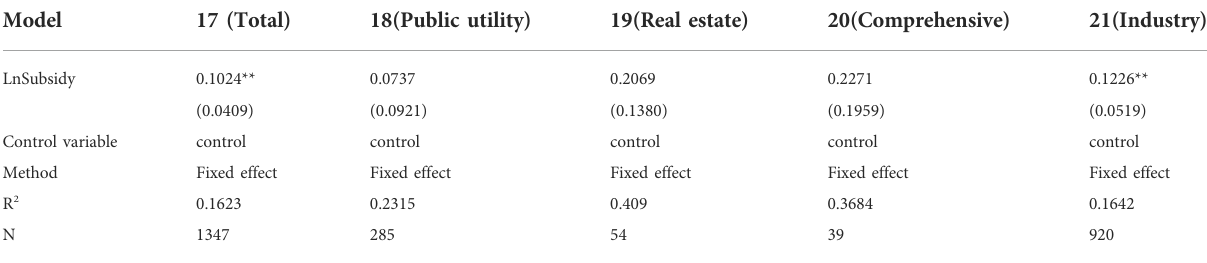
TABLE 8 Mechanism test.